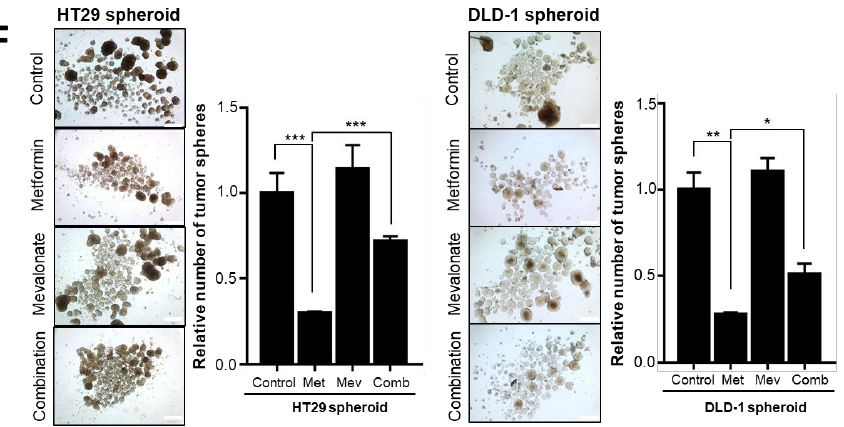
Figure 2. Regulation of enzymes of the mevalonate pathway and cancer stem cell population by metformin, AMPK activator, mTOR inhibitor, and mevalonate. ( A ) Heatmap analysis representing transcripts of enzymes of the MVA pathway using the same public RNA-sequencing data set as in Figure 1B. ( B ) Western blot analysis for the expression of FDPS and GGPS1 was performed after 5 days of 2D adherent culture and 3D tumor sphere culture and after 5 days’ treatment with metformin (10 mM). ( C ) mRNA levels of HMGCR, FDPS, GGPS1, and SQLE were measured by qPCR under the same conditions as in ( B ). ( D ) HT29 and DLD-1 tumor spheres were treated with metformin (10 mM), simvastatin (2 μM), AICAR (1 mM), rapamycin (200 nM), or mevalonate (1 mM) for 7 days and then subjected to qPCR analysis of HMGCR, FDPS, GGPS1, and SQLE. ( E ) HT29 and DLD-1 cells were treated with metformin (10 mM), simvastatin (2 μM), AICAR (1 mM), rapamycin (200 nM), mevalonate (1 mM), or a combination of each drug with mevalonate (1 mM) for 48 h. Cells were subjected to flow cytometry to analyze CD44+/CD133+ cells using anti-CD44-FITC and anti-CD133-PE. ( F ) In tumor sphere cultures with metformin (5 mM), mevalonate (1 mM), or a combination of metformin (5 mM) and mevalonate (1 mM) for 7 days, the number of tumor spheres ( ≥ 200 µm in diameter) was counted and compared to the counts in control cultures. Magnification, 40×. Data are expressed as the mean ± standard error of three independent experiments; * p < 0.05, ** p < 0.01, and *** p < 0.001 (compared with control).